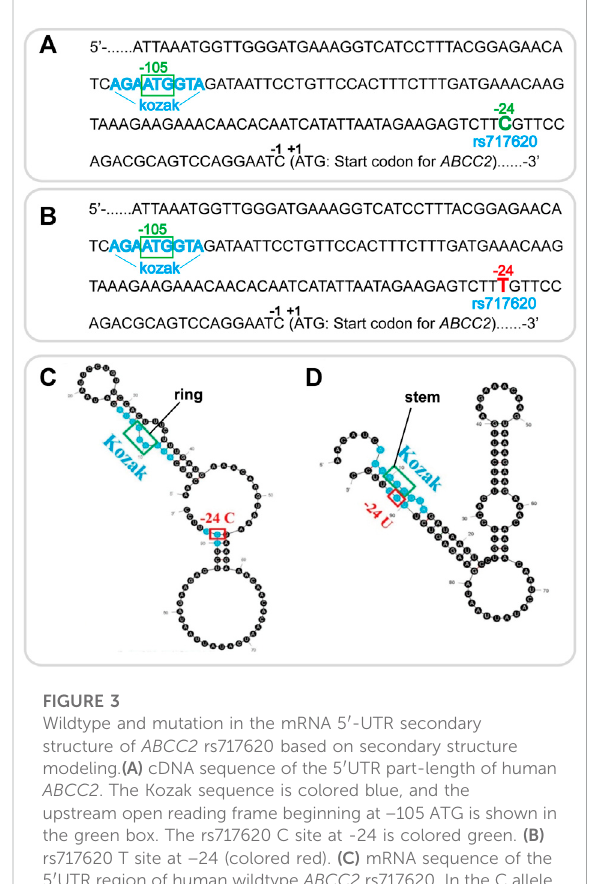
FIGURE 3 Wildtype and mutation in the mRNA 5 ′ -UTR secondary structure of ABCC2 rs717620 based on secondary structure modeling. (A) cDNA sequence of the 5 ′ UTR part-length of human ABCC2 . The Kozak sequence is colored blue, and the upstream open reading frame beginning at − 105 ATG is shown in the green box. The rs717620 C site at -24 is colored green. (B) rs717620 T site at − 24 (colored red). (C) mRNA sequence of the 5 ′ UTR region of human wildtype ABCC2 rs717620. In the C allele, the Kozak AUG sequence showed a “ ring ” structure, enabling Kozak to bind easily to the pre-translation initiation complex. (D) Complementary combination of the T allele and the Kozak sequence with AUG on the “ stem ” , showing the possibility of missing the opportunity for a complementary combination with the AUG of the Kozak sequence, resulting in missed